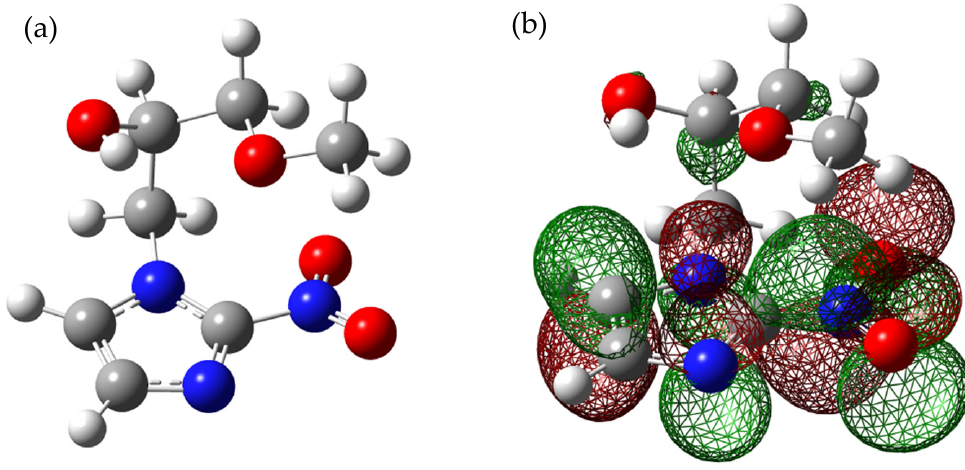
Figure 1. ( a ) Optimized molecular structure of misonidazole (MISO), ( b ) singly occupied molecular orbital of the MISO anion.